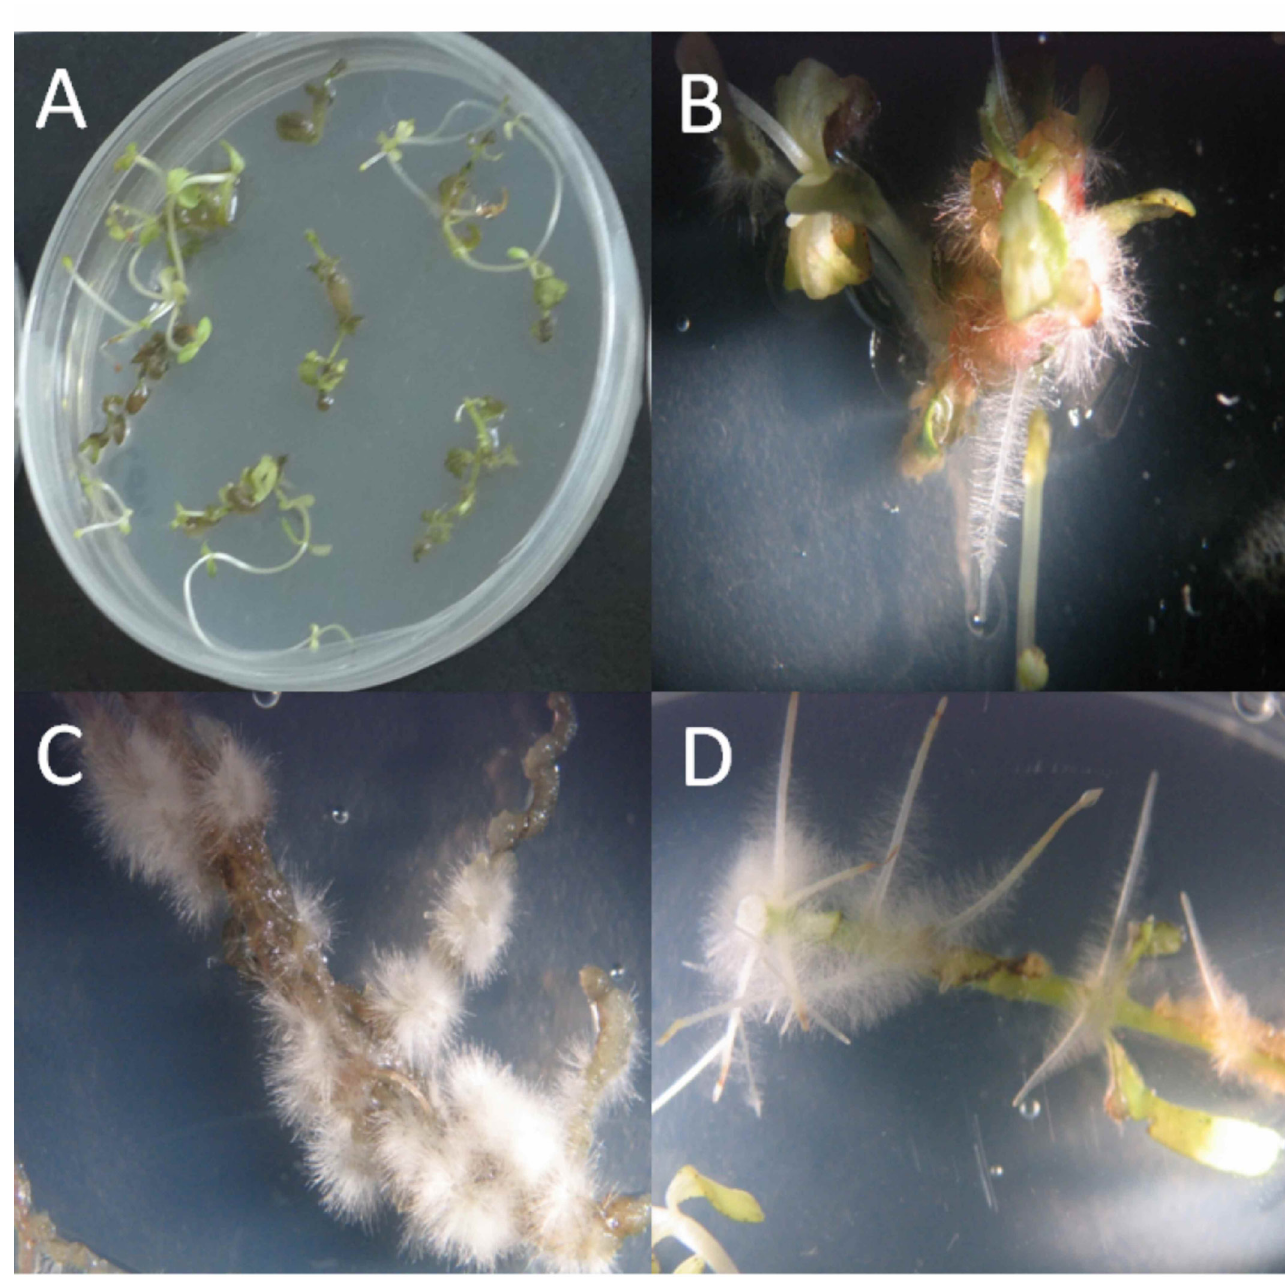
FIGURE 1 - Development of hairy roots on H. sinaicum explants. Control stem explants not inculated with bacteria (A), leaf (B), root (C) and stem (D) explants inoculated with the A4 A. rhizogenes strain and exposed to a solid MS